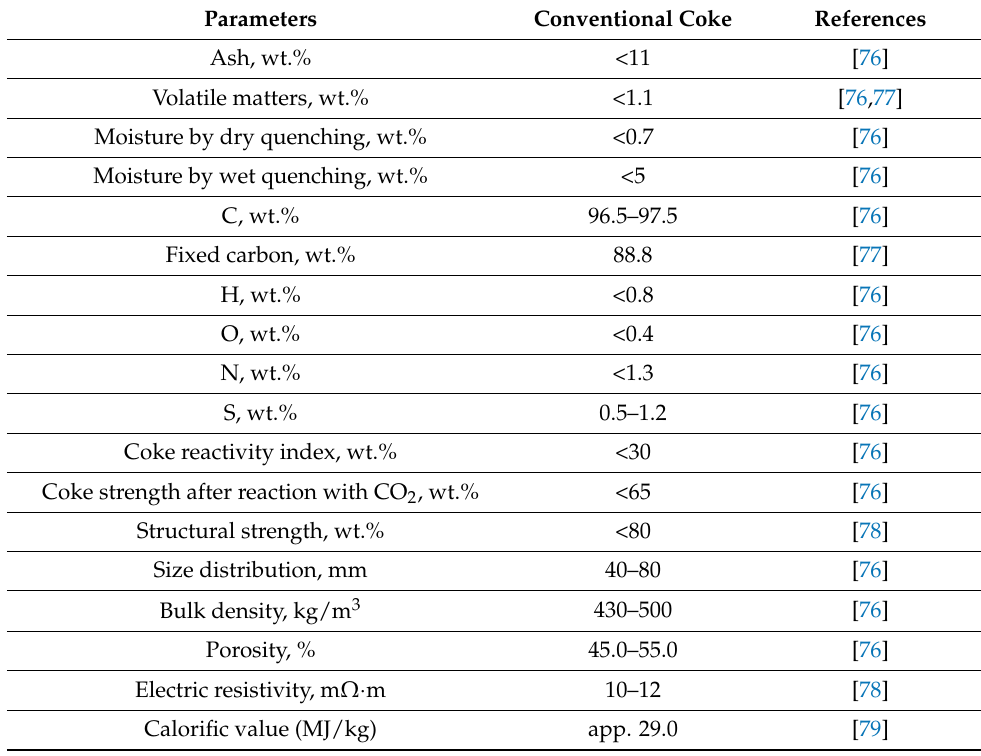
Table 1. Main properties required for conventional coke.